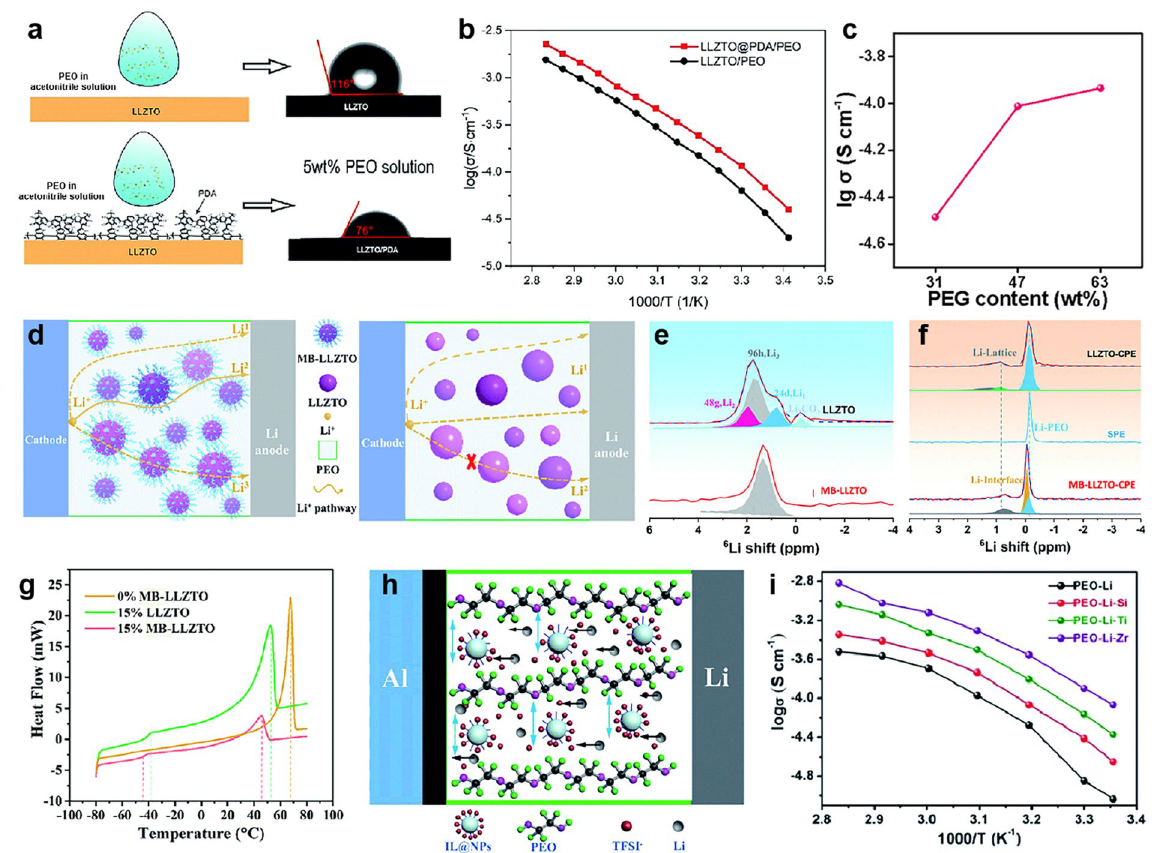
Fig. 9 a Schematic of dopamine polymerized on the surface of LLZTO particles to form a polydopamine coating layer and contact angle between the PEO solution (dissolved in acetonitrile) and pristine LLZTO or LLZTO@PDA. b Arrhenius plots of PEO/LLZTO@PDA and PEO/ LLZTO CSEs. a, b Reproduced with permission [123]. Copyright 2019, Royal Society of Chemistry. c Ionic conductivity of electrolyte mem- branes with different PEG contents. Reproduced with permission [80]. Copyright 2022, Elsevier. d Diagrams of the Li + diffusion pathway in the MB-LLZTO CSEs and LLZTO CSEs. e 6 Li NMR of LLZTO and MB-LLZTO materials. f 6 Li direct polarization NMR spectra and assignment results for the LLZTO and MB-LLZTO CSEs. The blue area represents Li in PEO, the orange area represents the interfacial Li, and the gray and green areas correspond to the LLZTO lattice in e , g DSC thermograms of electrolytes with different coating layers. d–g Reproduced with per- mission [98]. Copyright 2019, Royal Society of Chemistry. h Schematic illustration of ionic liquid grafted oxide nanoparticles (IL@NPs). i The ionic conductivity of CSEs with different IL@NP fillers at different temperatures. h‑i Reproduced with permission [169]. Copyright 2017, Royal Society of Chemistry. (Color figure